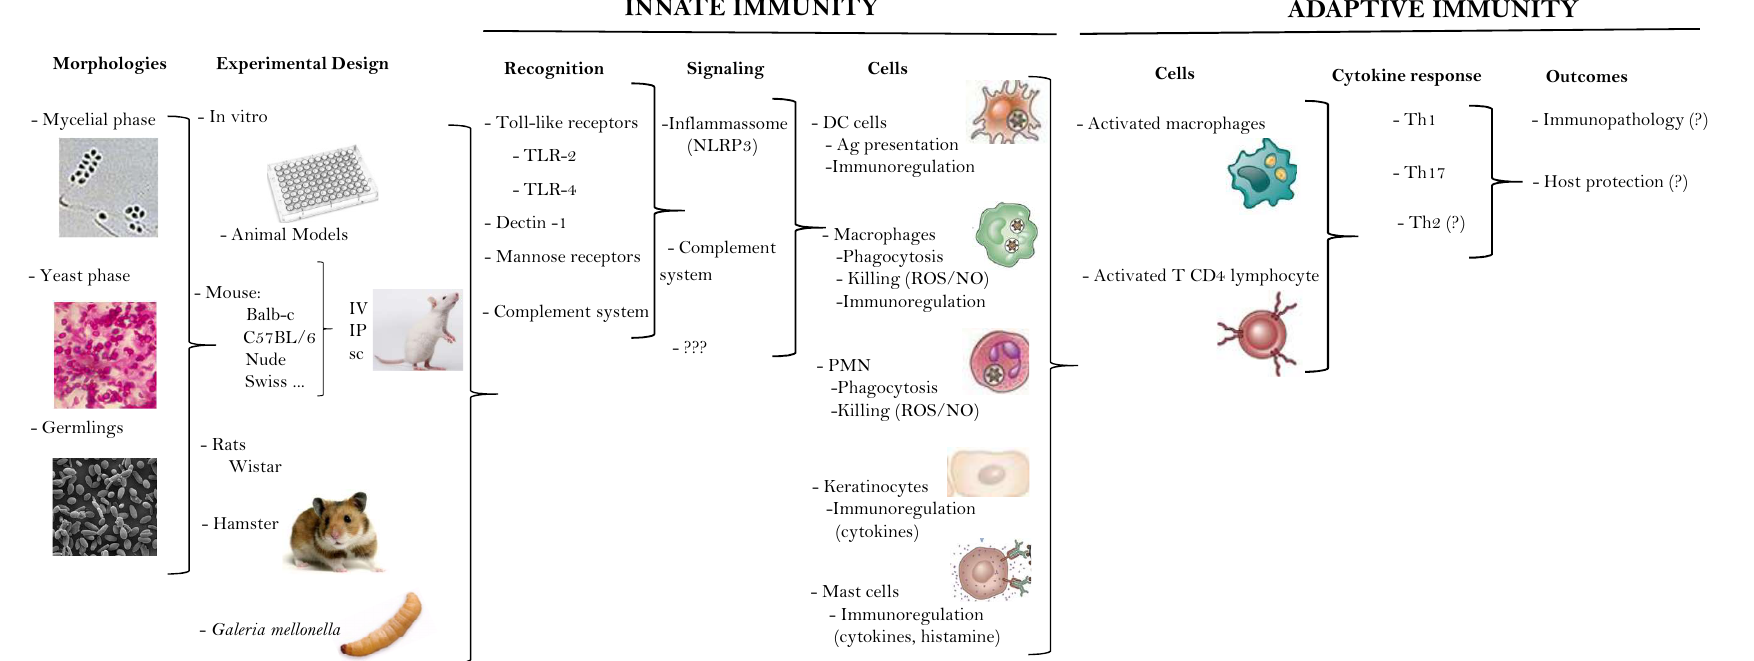
Figure 1. Schematic view of the data obtained from experimental studies of the immune response in sporotrichosis. IV: intravenous; IP: intraperitoneal; sc: subcutaneous; DC: dendritic cells; ROS: reactive oxygen species; NO: nitric oxide; PMN: polymorphonuclear cells; Th: T